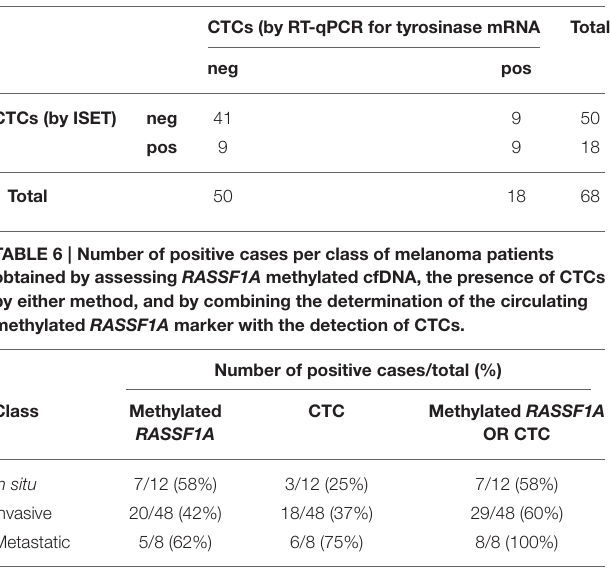
TABLE 5 | Distribution of positive and negative cases for the presence of CTCs as assessed by ISET and RT-qPCR for tyrosinase mRNA (Fisher’s exact test p = 0.013 ).